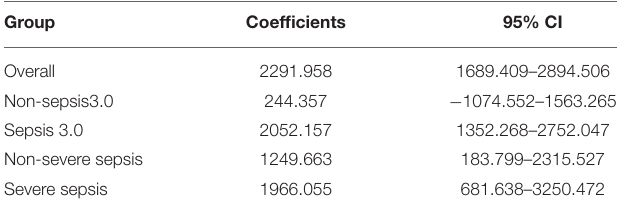
TABLE 3 | Coefficients in each linear regression